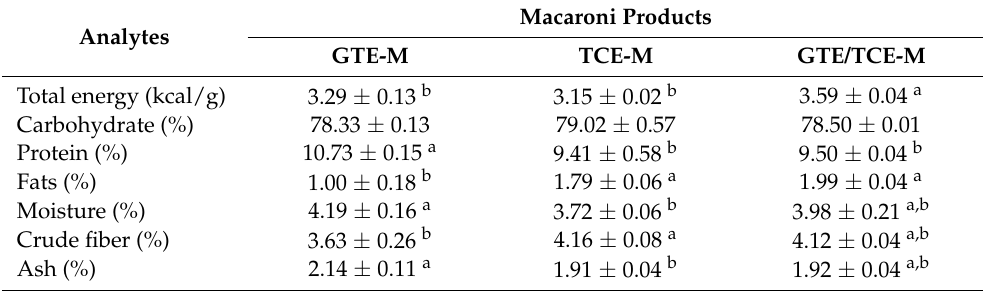
Table 2. Nutritional facts of three macaroni products. Data obtained from three independent repetitions are expressed as mean ± SD values. Within the same parameters, values followed by different superscript letters ( a,b ) are indicative of significant differences ( p <